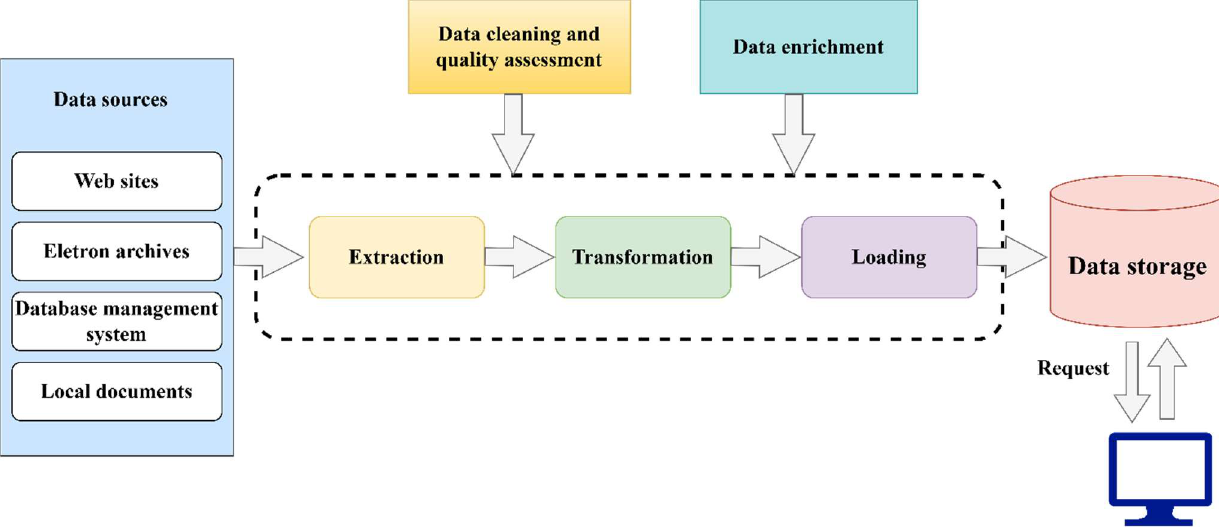
Figure 2. Data consolidation